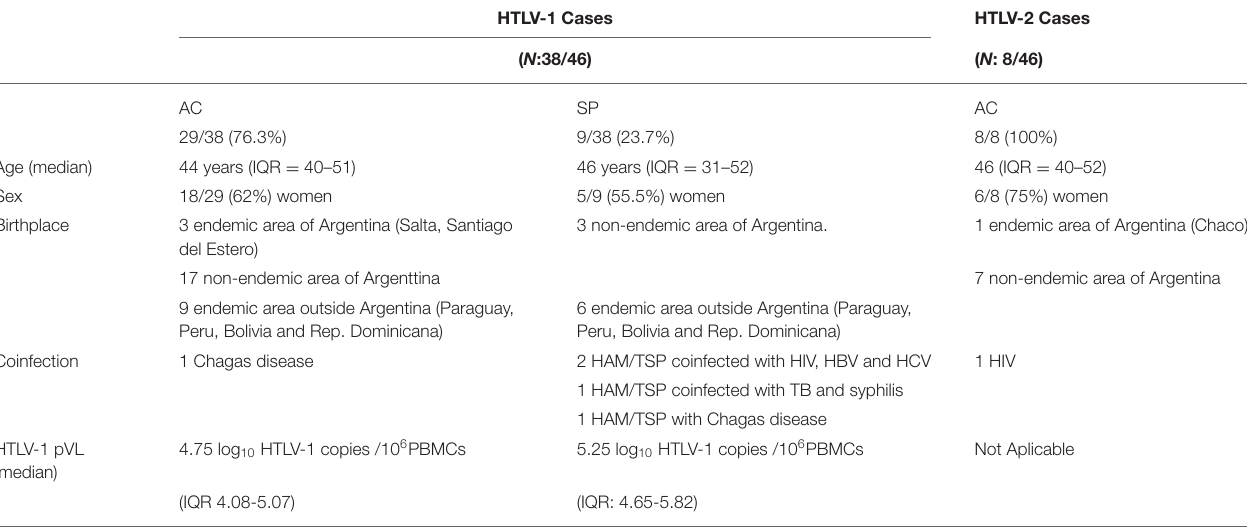
TABLE 2 | Summary of the demographic and clinical characteristics of the HTLV-1 and − 2 cases observed during follow-up.